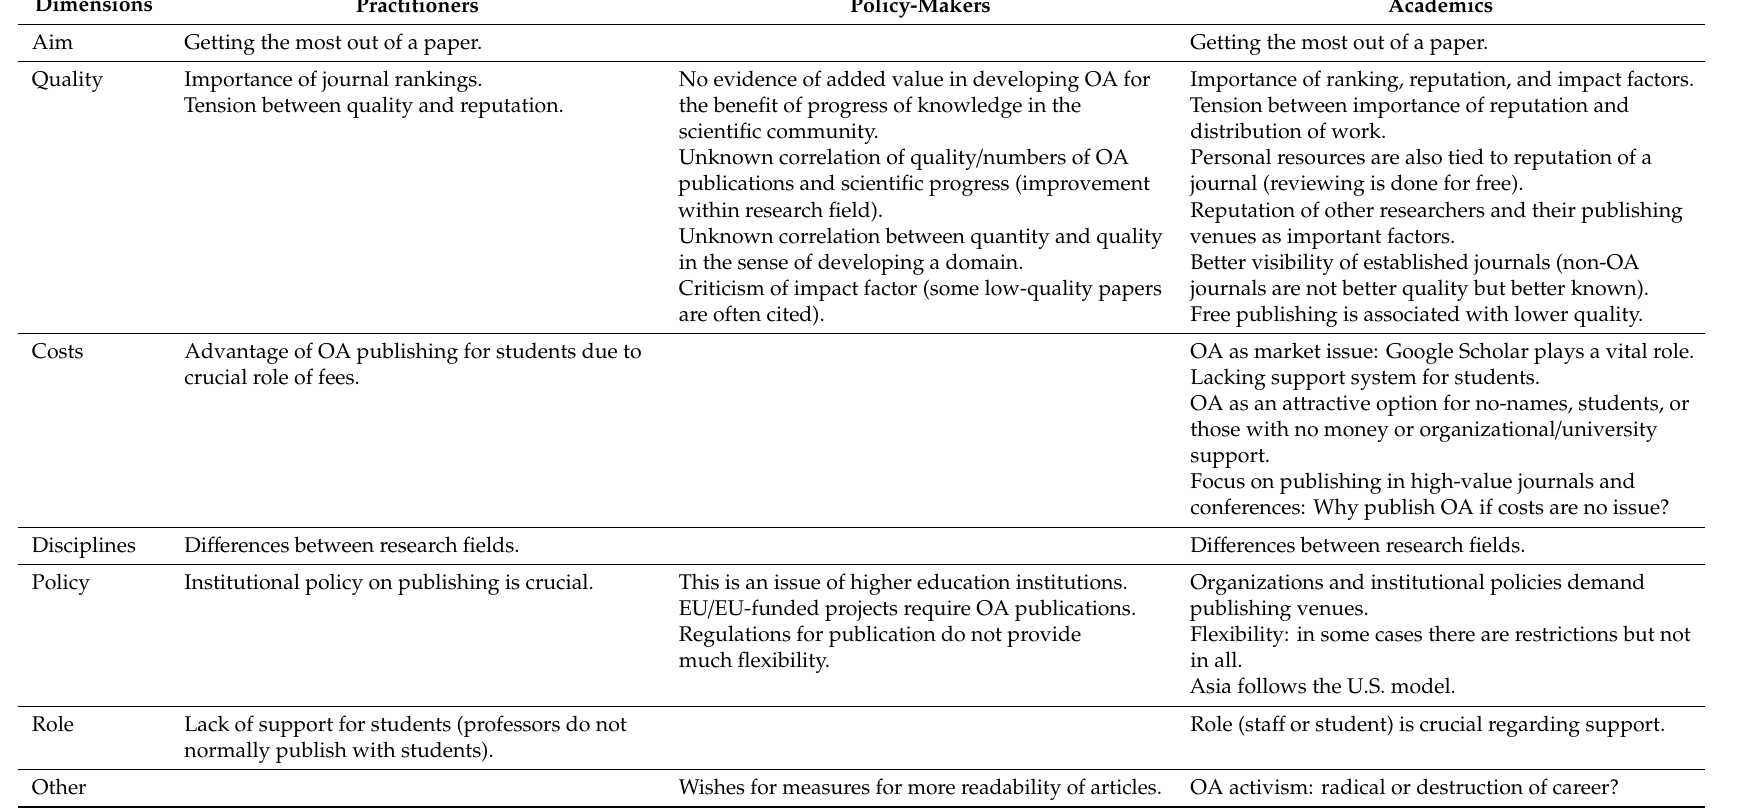
Table 1. Paraphrased results, stakeholder stances according to open access (OA) dimensions (workshops 1 and